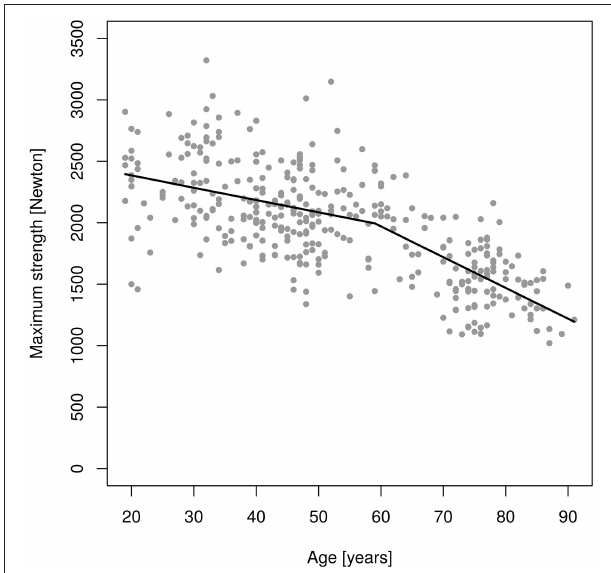
FIGURE 3 | Changes of maximum isokinetic hip/leg flexor strength (MIFS) during adulthood as determined by an isokinetic leg-press.